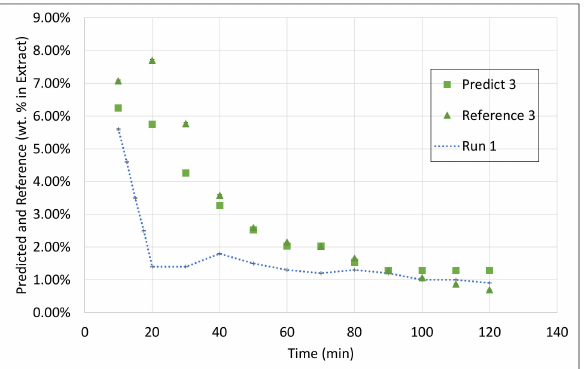
Figure 13. Extraction profiles with reference offline analytics and predicted with conductivity correlation for dry residue.